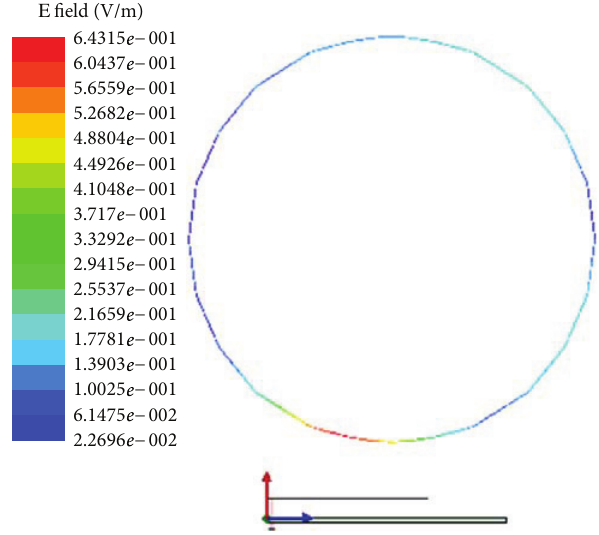
F 21: �-�eld strength in fat tissue at 900MHz.